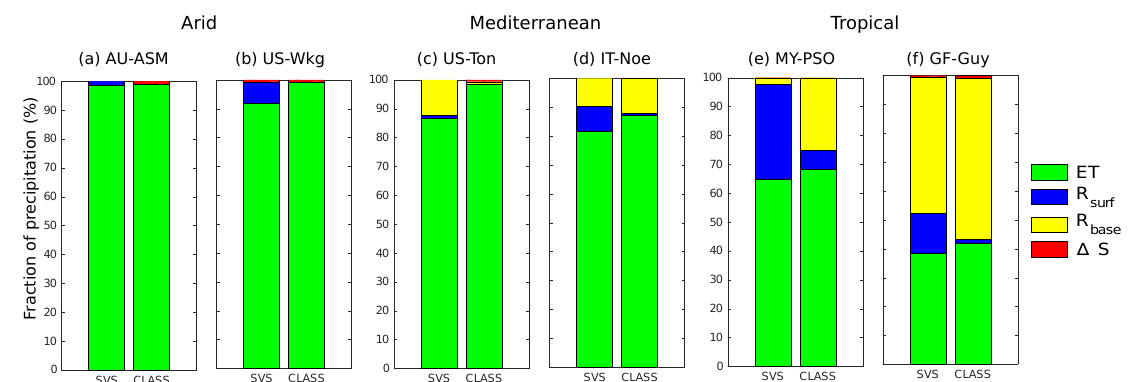
Figure 5. Partitioning of the precipitation into the different water balance terms, namely evapotranspiration, ET ( green ); overland flow, R surf ( blue ); base flow, R base ( yellow ); and storage in the soil column, ∆ S ( red ). The partition correspond to arid sites (( a ) AU-ASM, ( b ) US-Wkg), mediterranean sites (( c ) US-Ton, ( d ) IT-Noe) and tropical sites (( e ) MY-PSO, ( f )